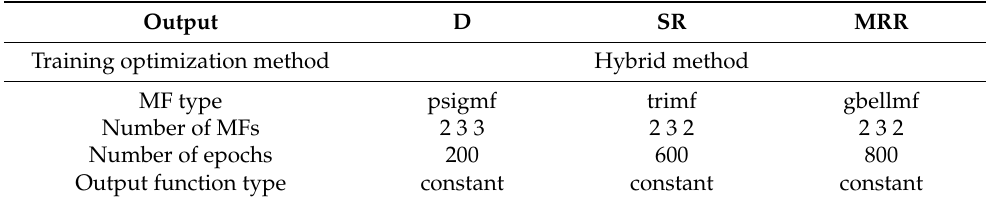
Table 7. Selected FIS parameters.